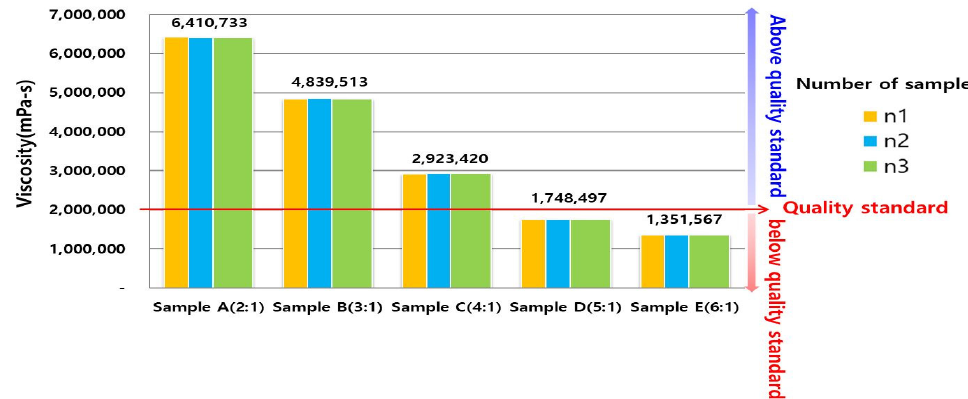
Figure 8. Viscosity value by sample of W-SPRG.